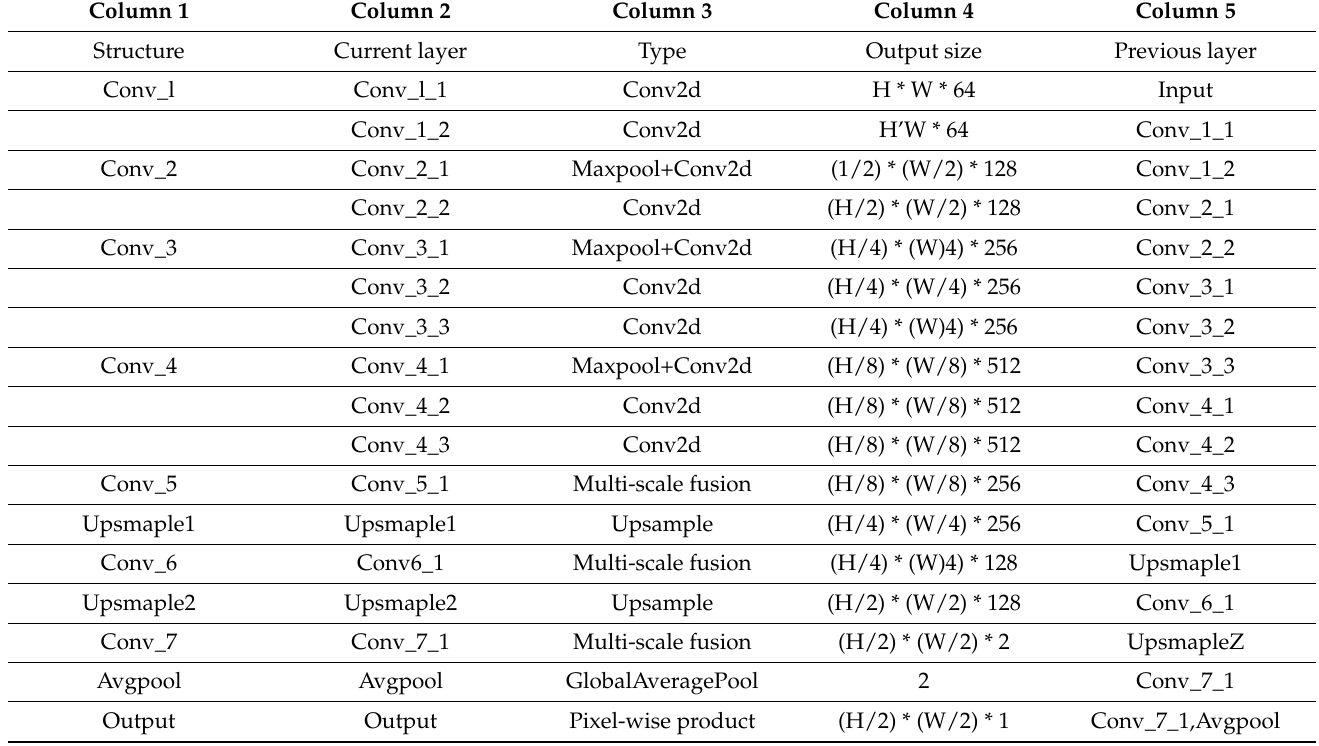
Table 9. Overall network of